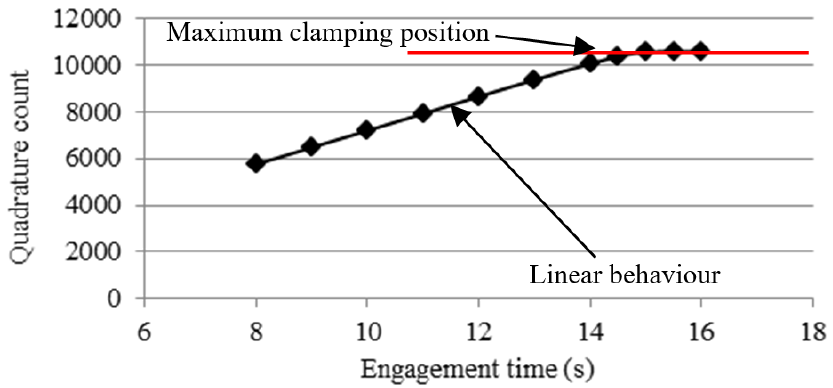
Figure 17. Engagement position (qc) versus engagement time.